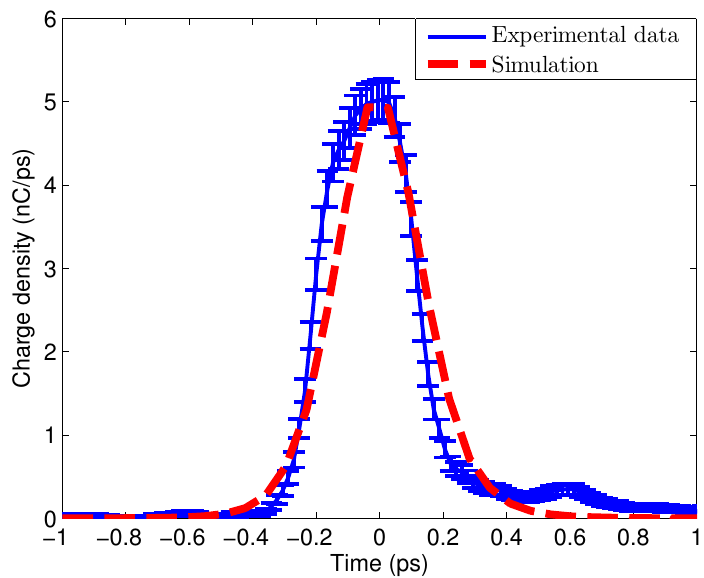
Figure 5. Single-shot temporal profile of the snapshot reported in Figure 4a. The profile is obtained by averaging a series of line-outs performed along the time direction (white arrows), compared with the corresponding profile provided by the numerical simulation of Figure 4d (red dashed line). The error bars are calculated as the standard deviation of line-outs’ average